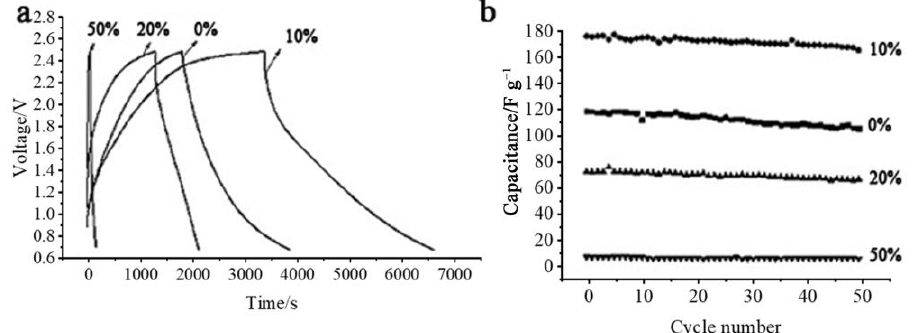
Figure 5. (NCM111+AC)//LTO LIBCs: ( a ) Charge and discharge voltage profile; ( b ) Cycle perfor- Figure 5. (NCM111 + AC)//LTO LIBCs: ( a ) Charge and discharge voltage profile; ( b ) Cycle mance [50]. performance